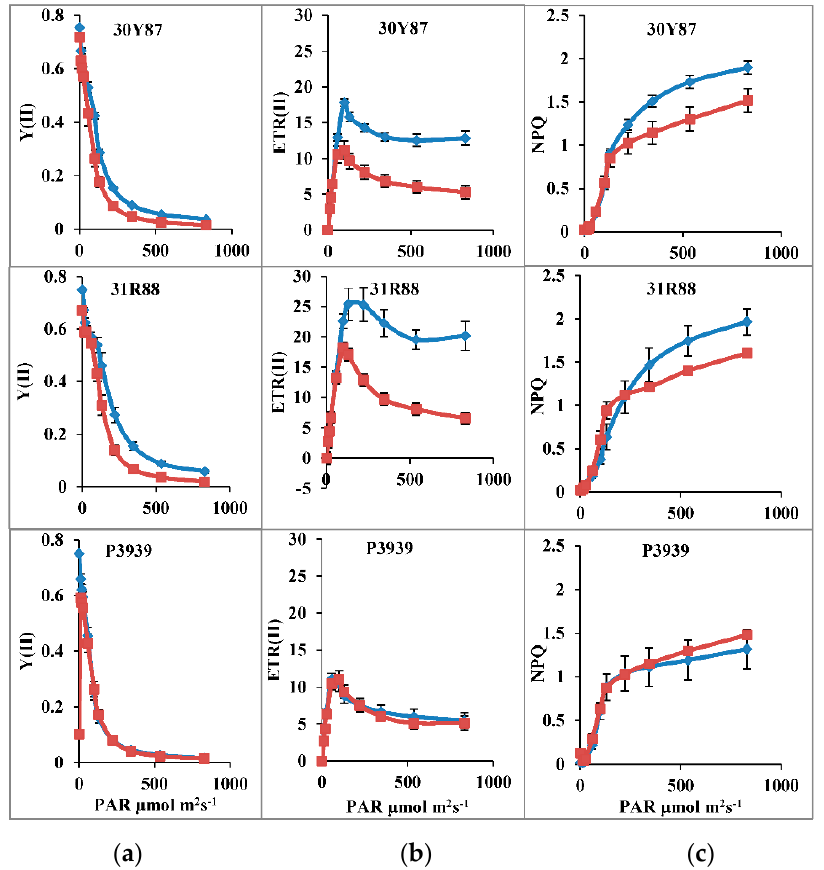
Figure 1. Analysis of PSII photochemistry of three maize hybrids when two-week-old plants were subjected to three cycles of drought stress. ( a ) Effective quantum yield of electron transport at PSII [Y(II)]; ( b ) Electron transport rate through photosystem II [ETR(II)]; ( c ) Nonphotochemical quenching (NPQ). Blue lines are control, red lines with markers are water stress. Bars represent the calculated standard error ( n = 4).